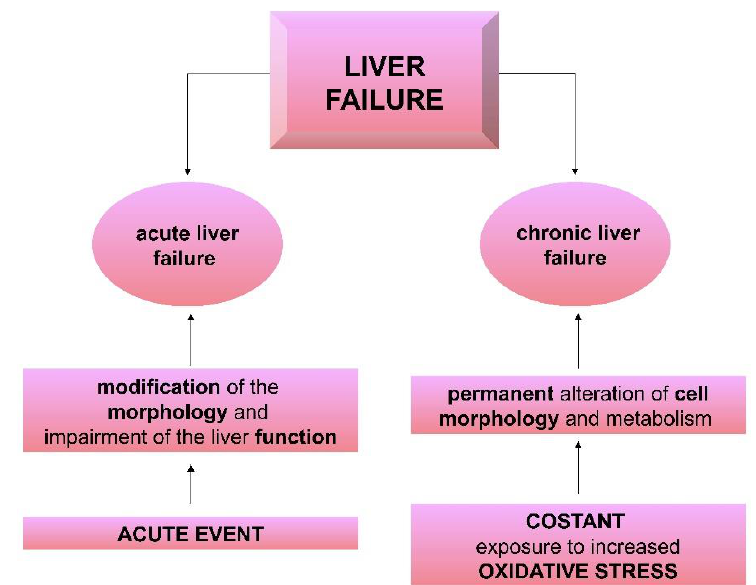
Figure 2. Schematic classification of liver failure, underlining the different mechanisms behind the evolution of the disease.